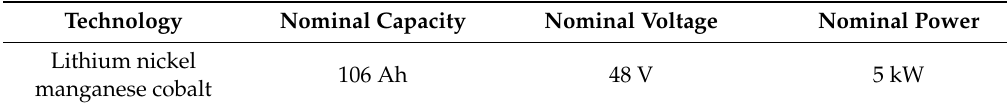
Figure 5. Efficiency curve of the battery inverter. Table 1. Specifications of the modeled battery.